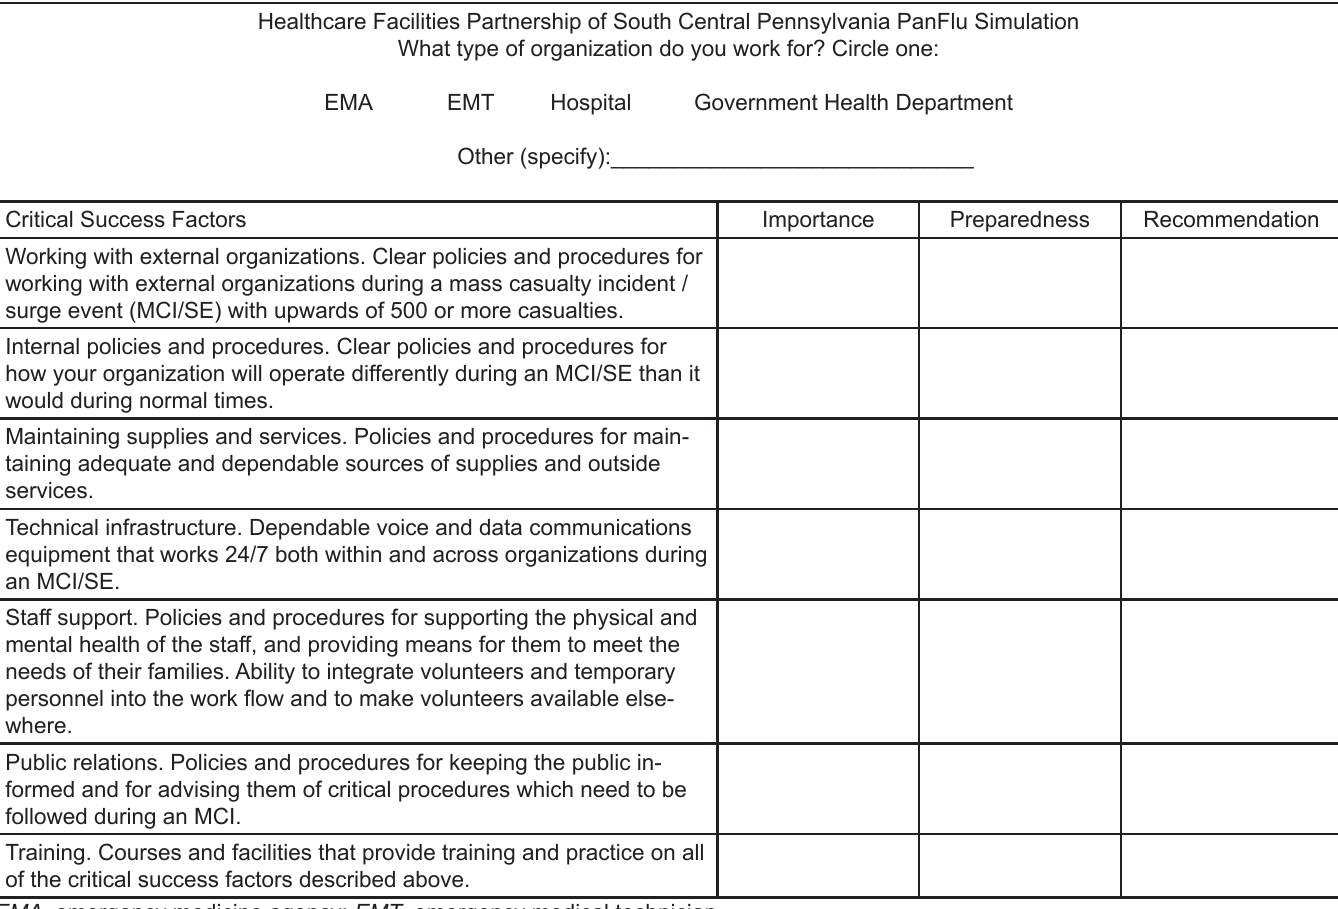
Table 2. Sample survey data collection tool used in the simulation workshop